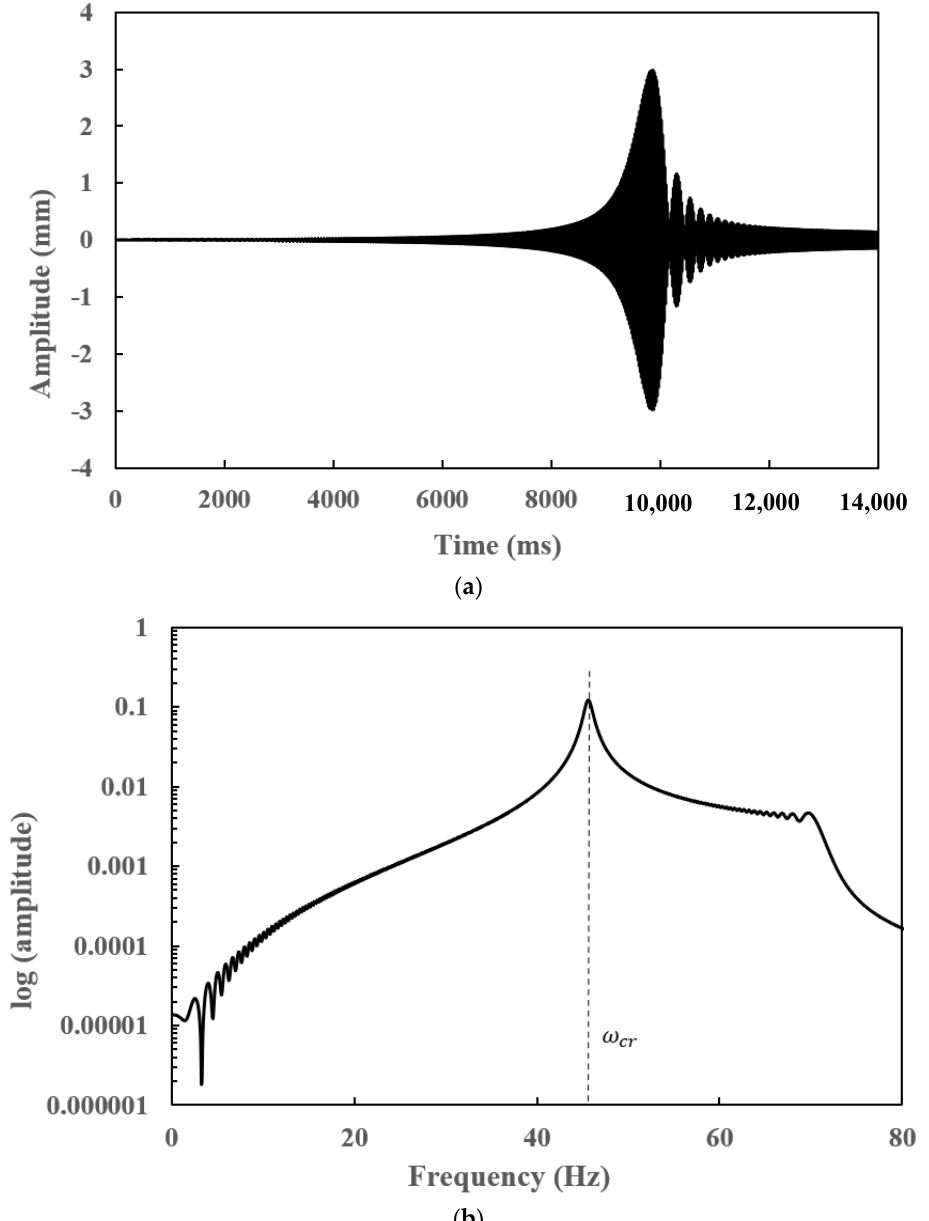
Figure 13. Transient ( a ) time response and corresponding ( b ) FFT of an uncracked EG rotor − bearing system with an angular acceleration of 30 rad/s 2 .